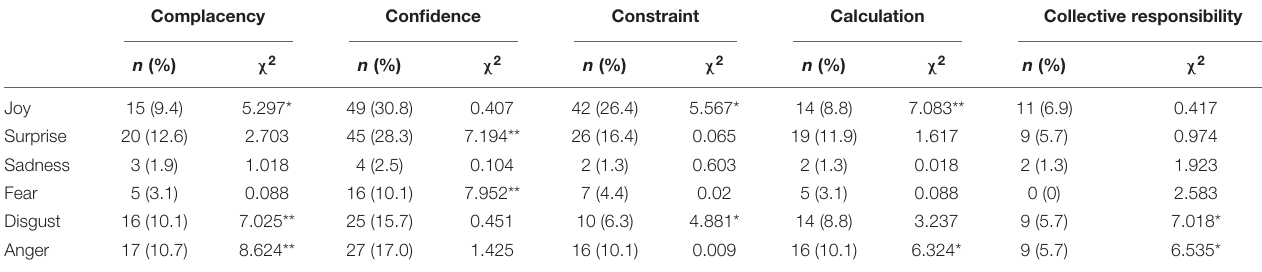
TABLE 2 | The chi-square ( χ 2 ) test of emotions and vaccine beliefs. Complacency Confidence Constraint Calculation Collective